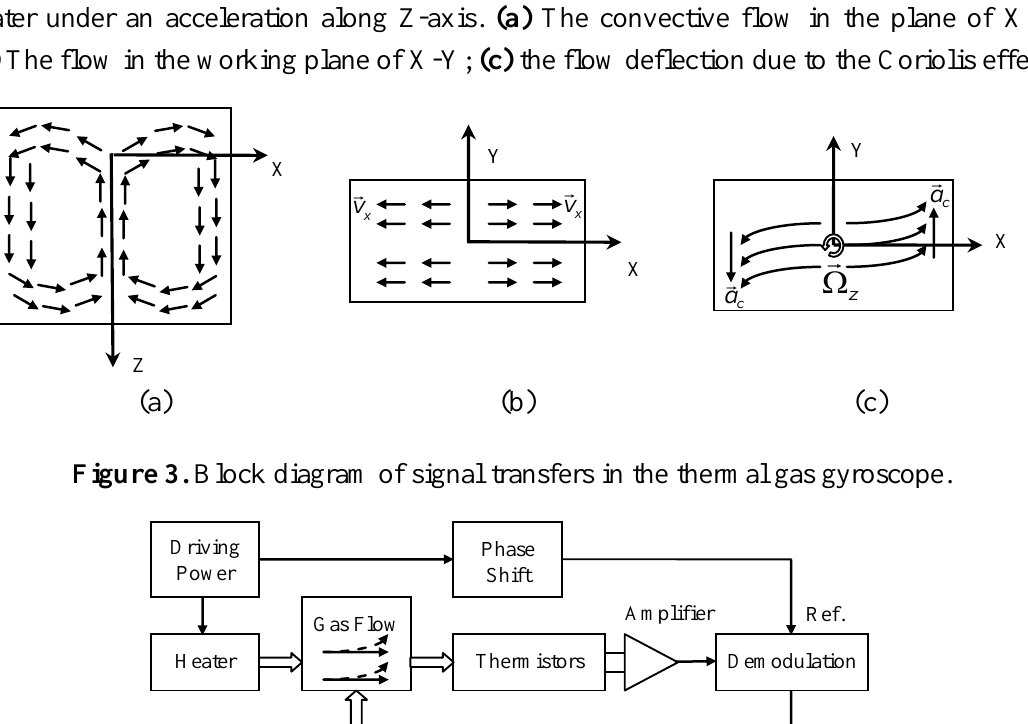
Figure 2. The convection field in region of hermetic chamber driven by heating the central heater under an acceleration along Z-axis. (a) The convective flow in the plane of X-Z;